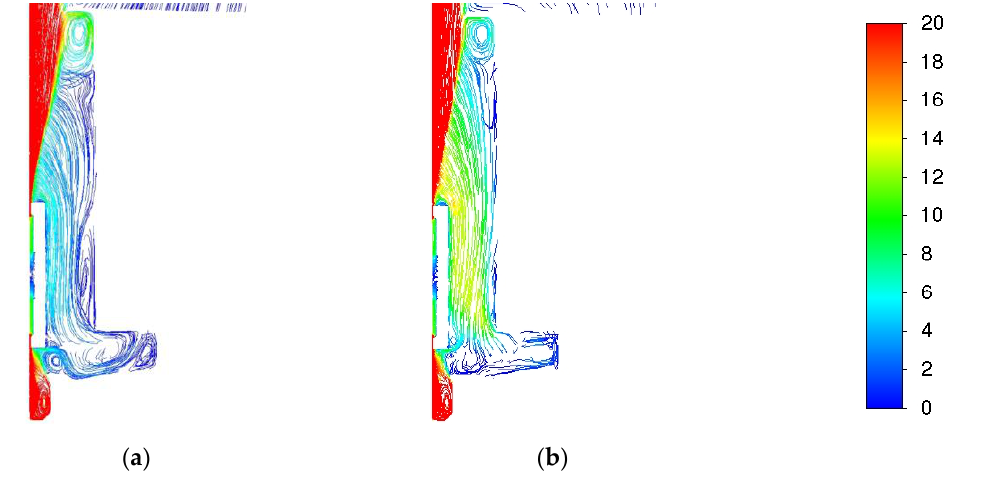
Figure 11. Streamlines, m/s (limited by the value of 20 m/s): ( a ) EDC; ( b ) Flamelet-PDF.